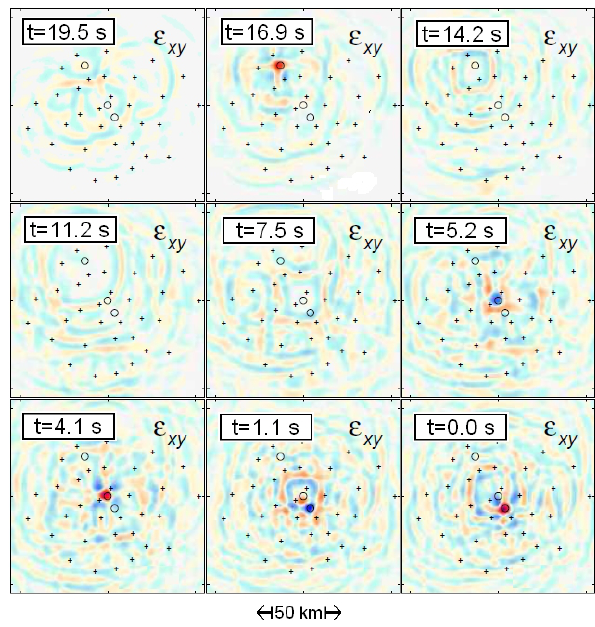
Fig. 4. Snapshots of the time-reversed strain field (cid:15) xy at 12 . 5km depth. Receiver and source locations are indicated by + and ◦ , re- spectively. Focussing at all three source locations can be observed with an uncertainty of ∼ 5km in space and ∼ 1s in time. The ob- served hypothetical rupture velocity is 2 ± 0 . 3kms − 1 , compared to 2kms − 1 used to generate the forward wave field.